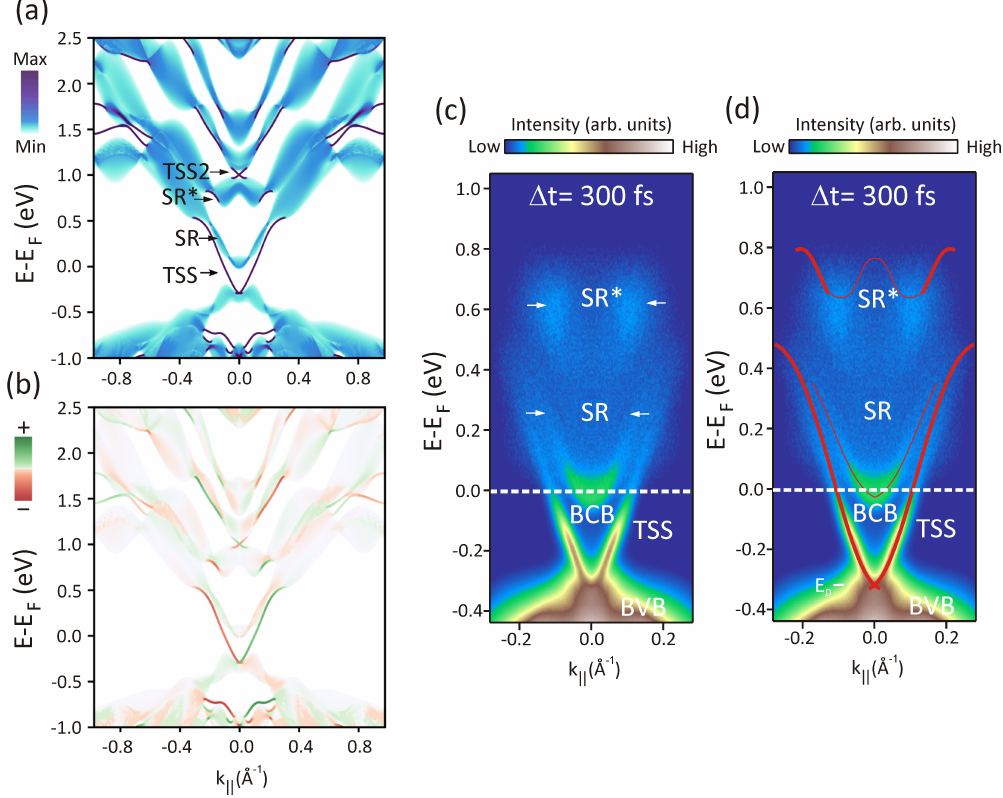
Figure 2. ( a ) band structure of a 100 quintuple layers slab of Bi 2 Te 3 obtained with a tight-binding model based on GW . The color scheme represents the localization of the states on the topmost quintuple layer; ( b ) corresponding calculations of the spin polarization, obtained as the expectation value of the σ y Pauli matrix. The color map represents the magnitude and direction of the spin polarization component perpendicular to the electron momentum; ( c ) snapshot of the Bi 2 Te 3 band structure measured 300 fs after laser excitation; ( d ) comparison to the GW calculated band dispersions, superimposed as red solid lines on the data shown in ( c